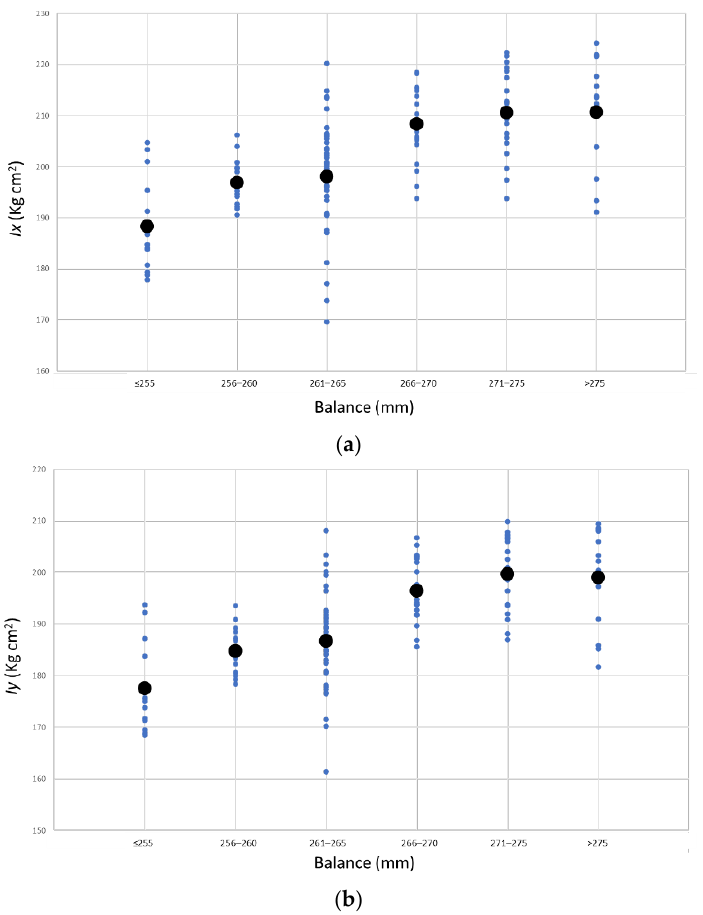
Figure 15. Moments of inertia I x ( a ) and I y ( b ) and median values as a function of the balance dis- tance.